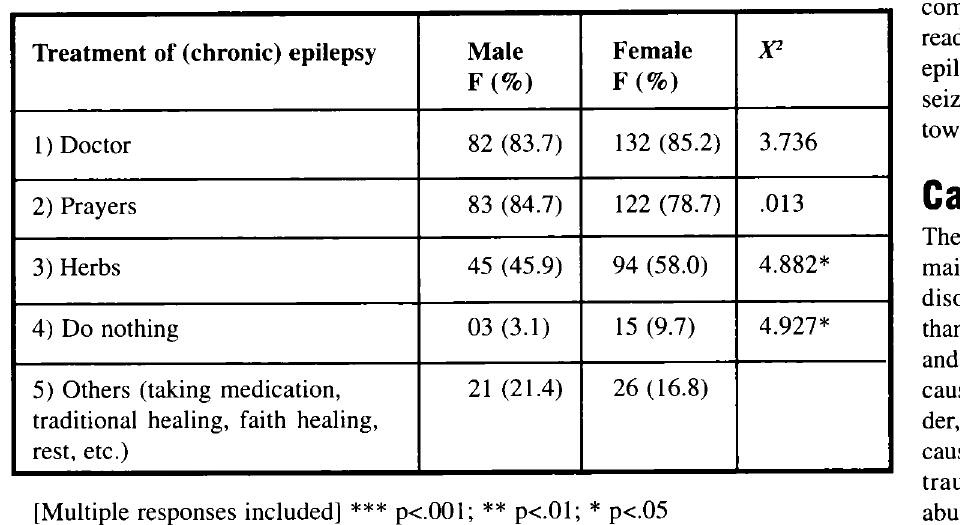
Treatment of (chronic) epilepsy